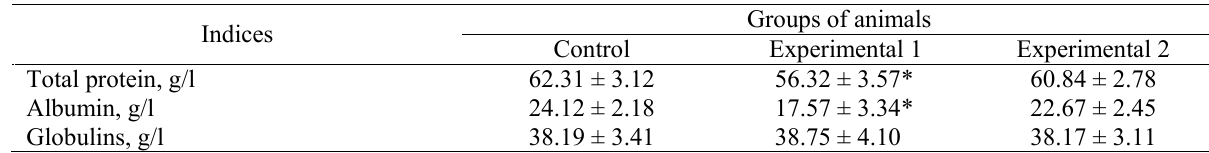
Protein synthesizing function of rat liver in experimental modeling of heart failure and action of “Bendamin” preparation (M ± m, n = 6)